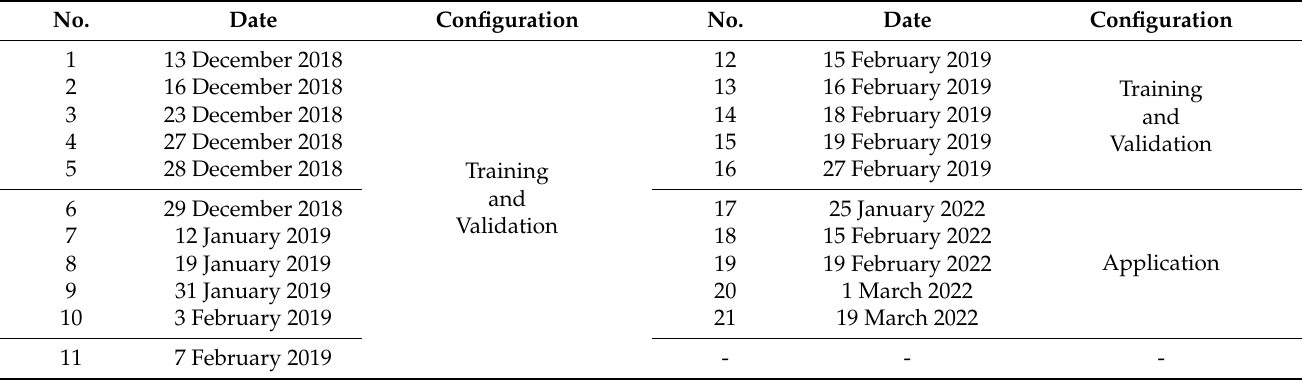
Table 1. List of precipitation events for training, validation, and application.